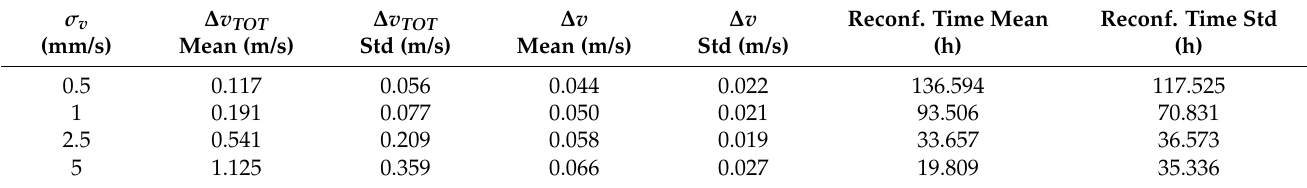
Table 5. Statistics related to the sensitivity analyses for maintenance of Sun-synchronous formations in the presence navigation errors ( σ p = 1